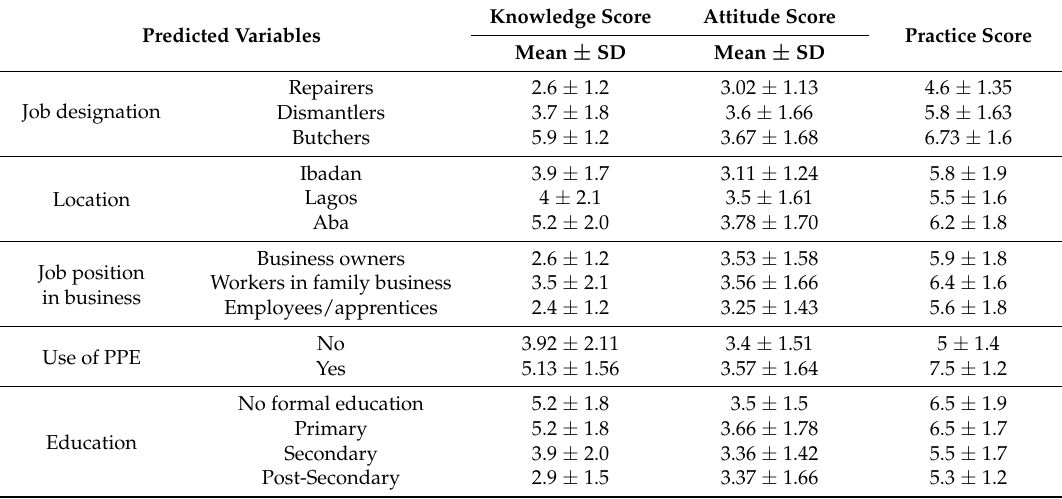
Table 1. Knowledge, attitude, and practice mean scores by job designation, location, job position, use of Personal Protective Equipment (PPE), and